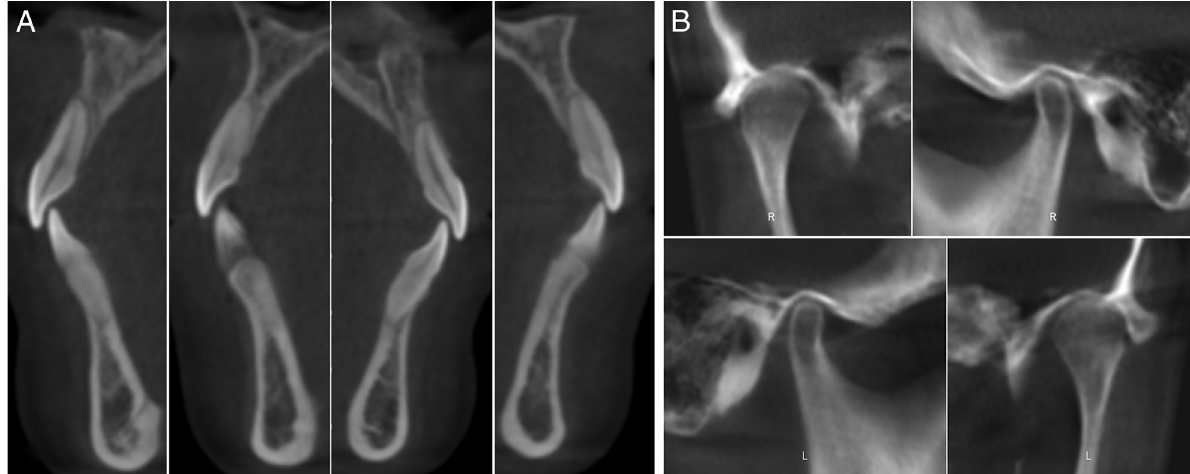
Figure 12. The post-treatment labial and lingual bone volume of anterior teeth (A) and temporomandibular joint radiograph (B).